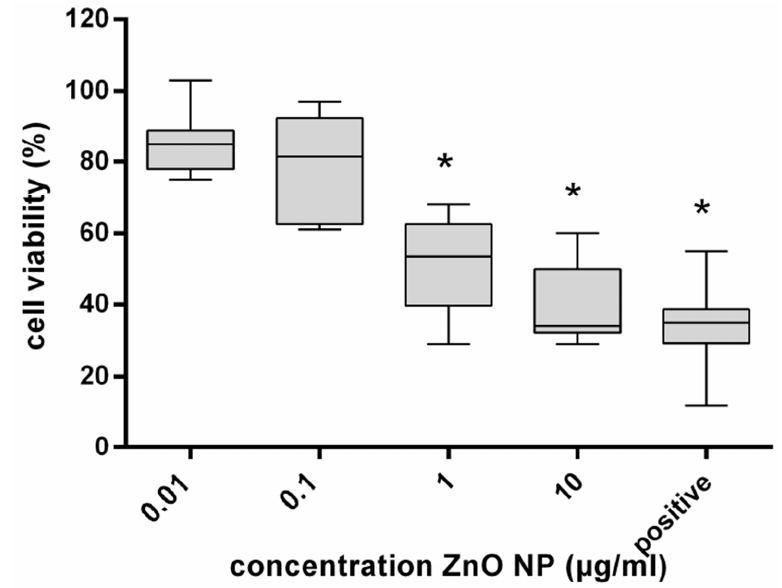
Figure 2. Viability of human mesenchymal stem cells (hMSC) after repetitive exposure to ZnO-NP; n = 8. The untreated control was defined as 100%. A quantity of 200 µ M tert-butylhydroperoxide (t-BHO) served as positive control. The box plots show the lowest and highest values of viable cells as well as the median. A significant decrease of hMSC viability (%) was observed after exposure to ZnO-NP concentrations of 1 and 10 µ g/mL. For statistical analysis, the Wilcoxon Test was performed. *: Statistical significance compared with the control based on a p -value < 0.05.